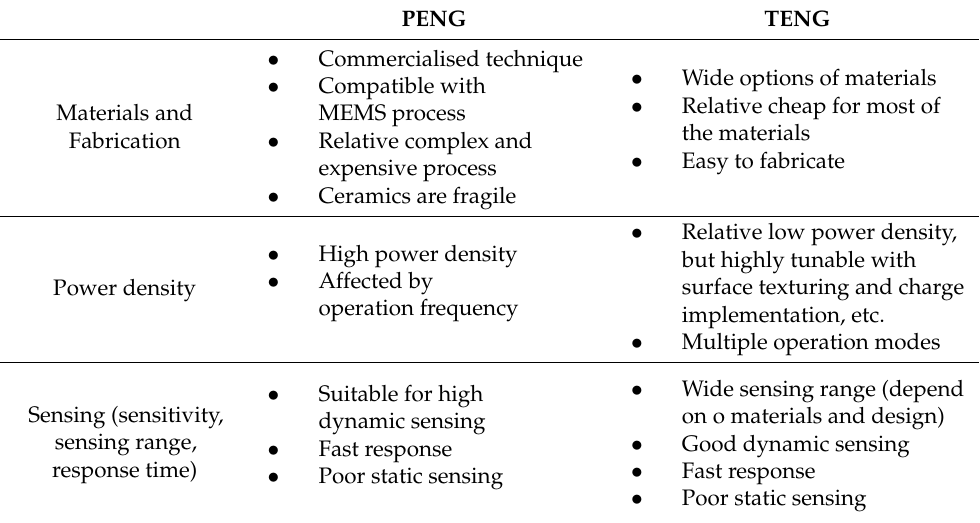
Table 3. Macroscopic differences between piezoelectric and triboelectric harvesting solutions